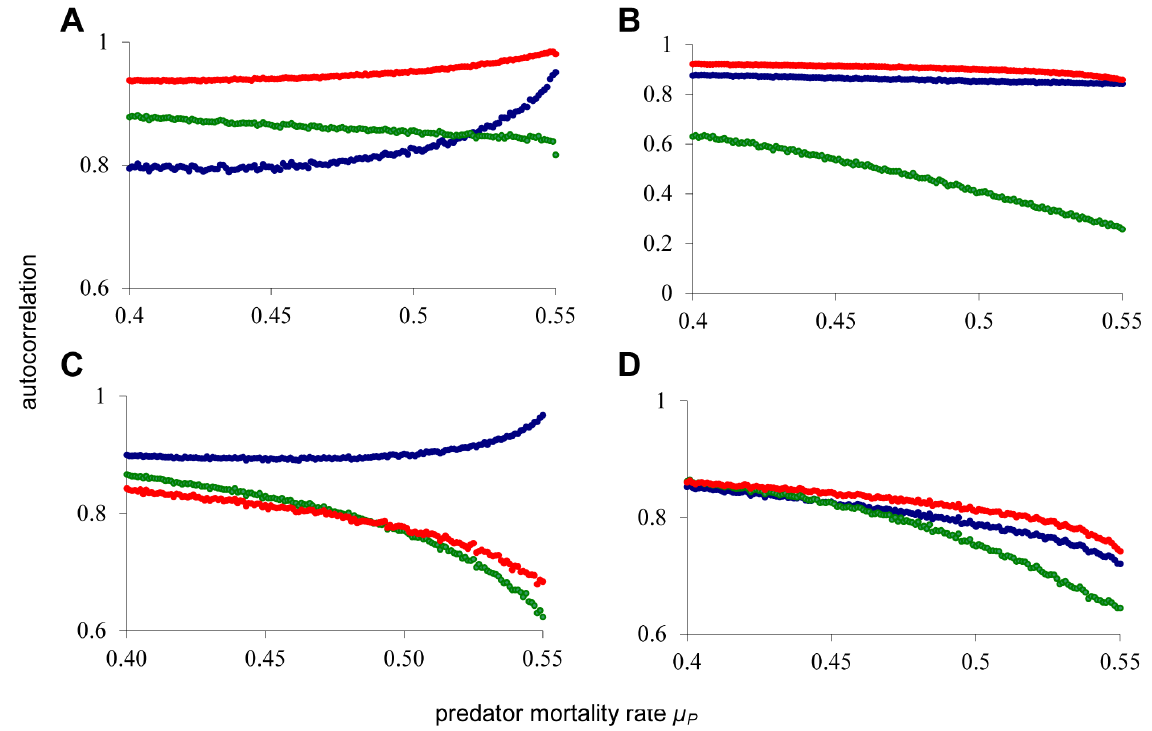
Figure 3. Early warning signals in autocorrelation. For the same simulation as in Figure 2, the lag-1 autocorrelation is computed over the last 50,000 time units. ( A ) Noise added to the death rate of the juvenile population ( B ). Noise added to the death rate of the adult population ( C ). Independent noise added to the death rates of all three populations. ( D ) Identical, fully correlated, noise added to the death rates of all three populations. For description of the simulation and for color index see Figure 2.